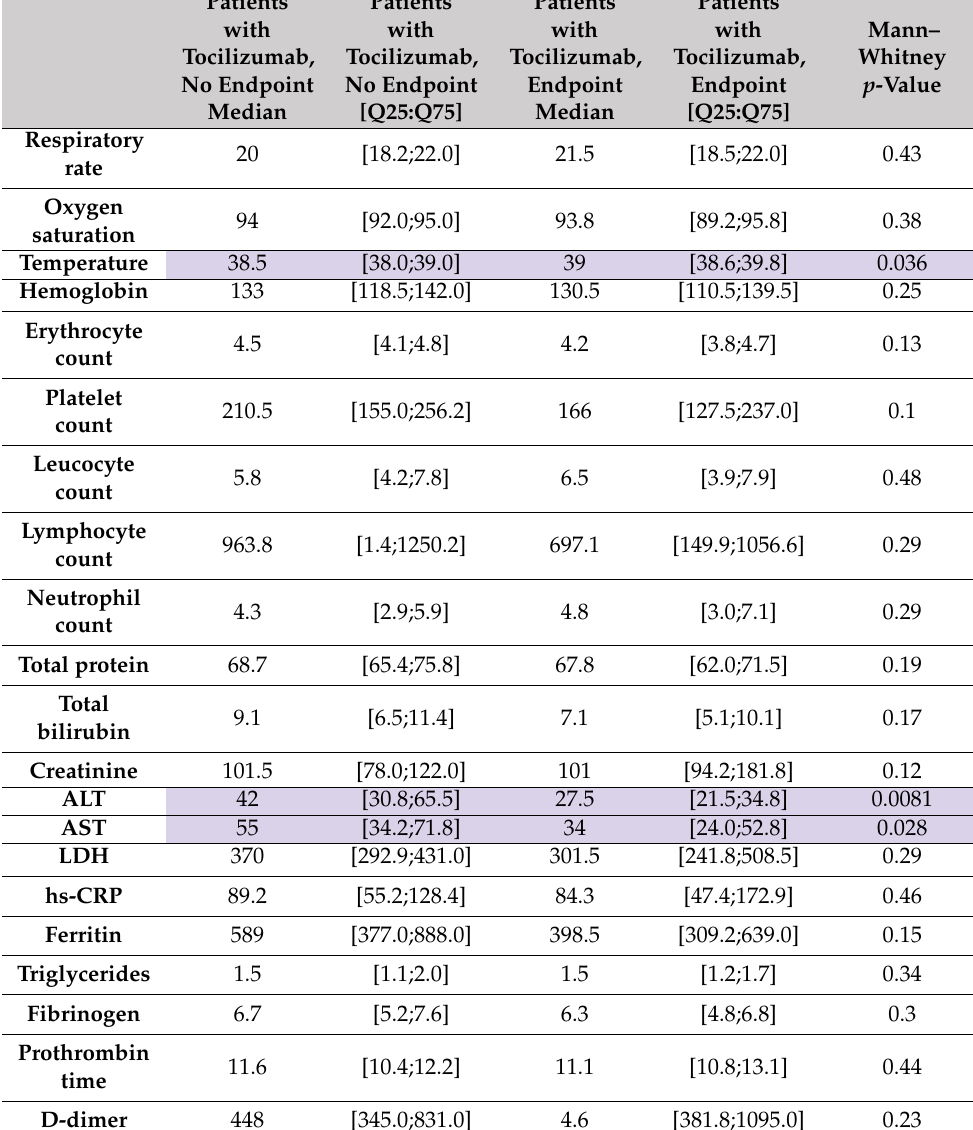
Table 7. Comparison of laboratory and clinical parameters at admission between patients with and without combined endpoint in patients receiving tocilizumab. Data are presented as median and interquartile range [Q25;Q75]. p -values are presented according to the Mann–Whitney test. Patients Patients Patients Patients with with with with Mann– Tocilizumab, Tocilizumab, Tocilizumab, Tocilizumab, No Endpoint No Endpoint Endpoint Median [Q25:Q75] Median